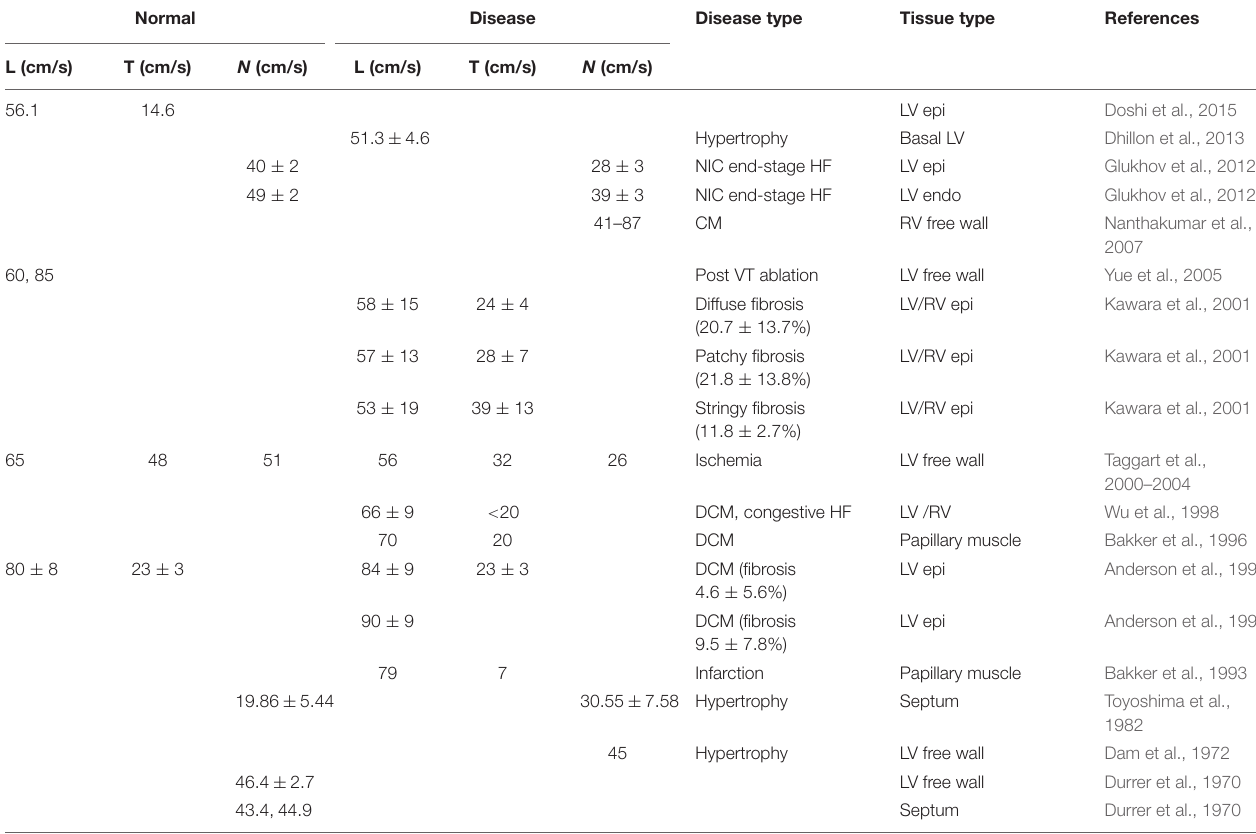
TABLE 4 | Clinical and experimental measures of CV in human cardiac